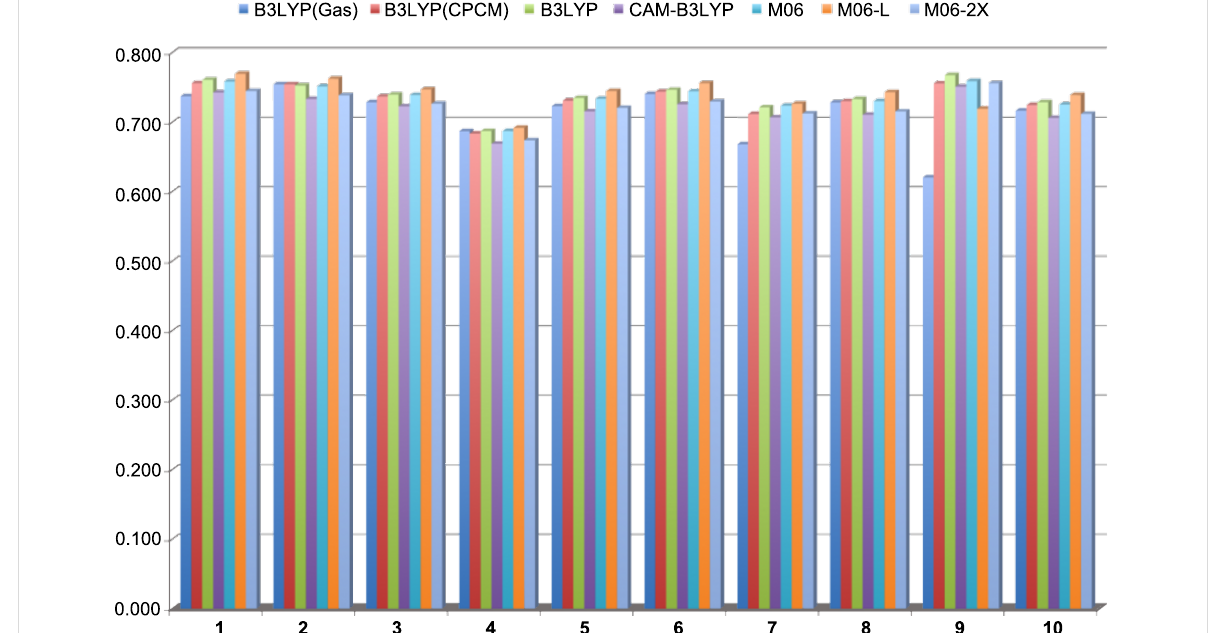
Figure 5: The orbital overlaps ( Λ ) for each dye at the different levels of theory investigated. All structures were optimized in the gas-phase at the B3LYP/6-311++G(d,p) level of theory. B3LYP(Gas) refers to the TD-B3LYP calculation in the gas-phase. B3LYP(CPCM) refers to the TD-B3LYP calculation within the CPCM solvent model. All other TD-DFT calculations were carried out using the SMD solvent model as described in the compu- tational